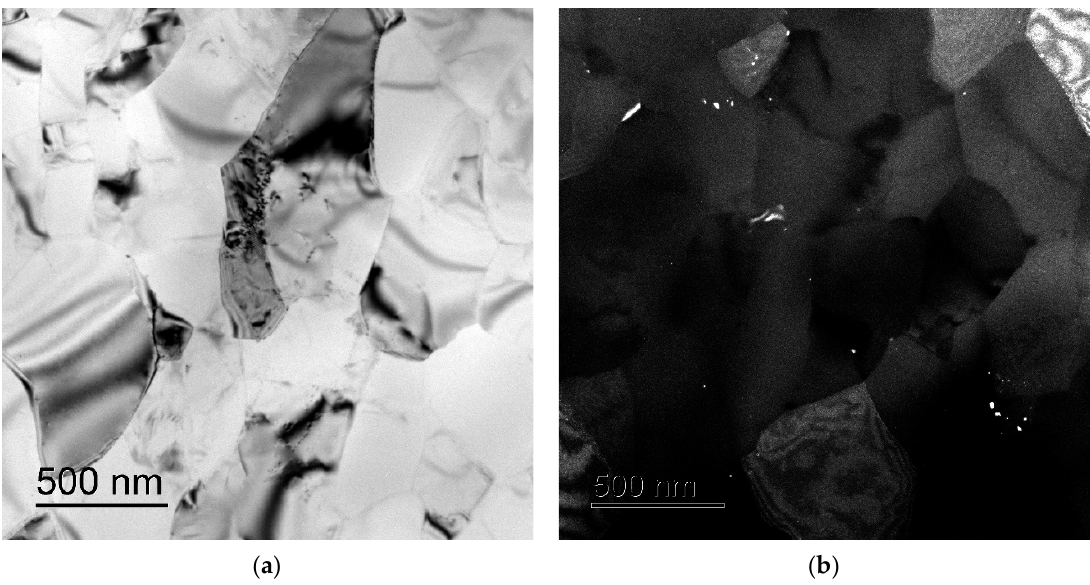
Figure 2. Bright-field ( a ) and dark-field ( b ) images of UFG alloy No. 5 microstructure after ECAP. TEM.